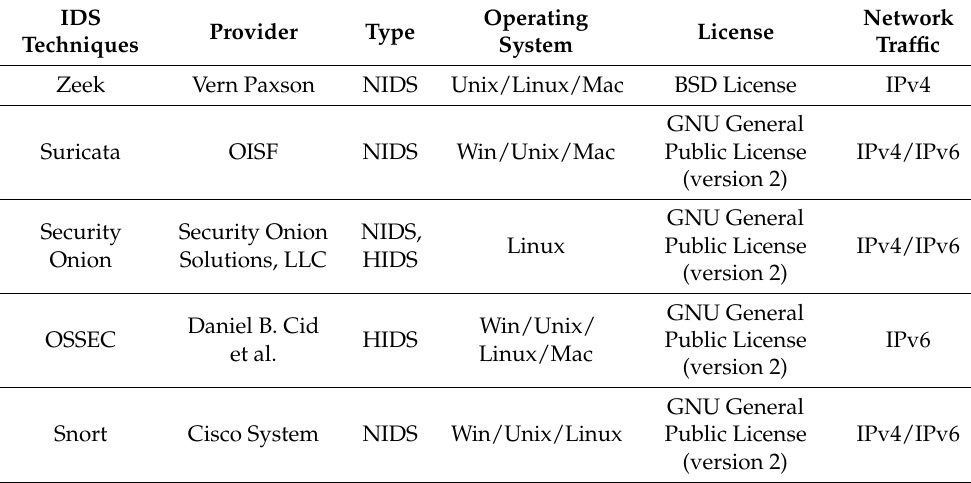
Table 1. Comparison of the five intrusion-detection